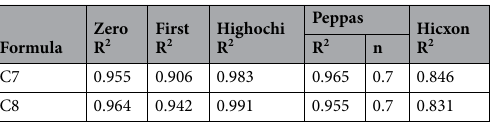
Table 6. Results of the in vitro drug release kinetics of C7 and C8 formulations.